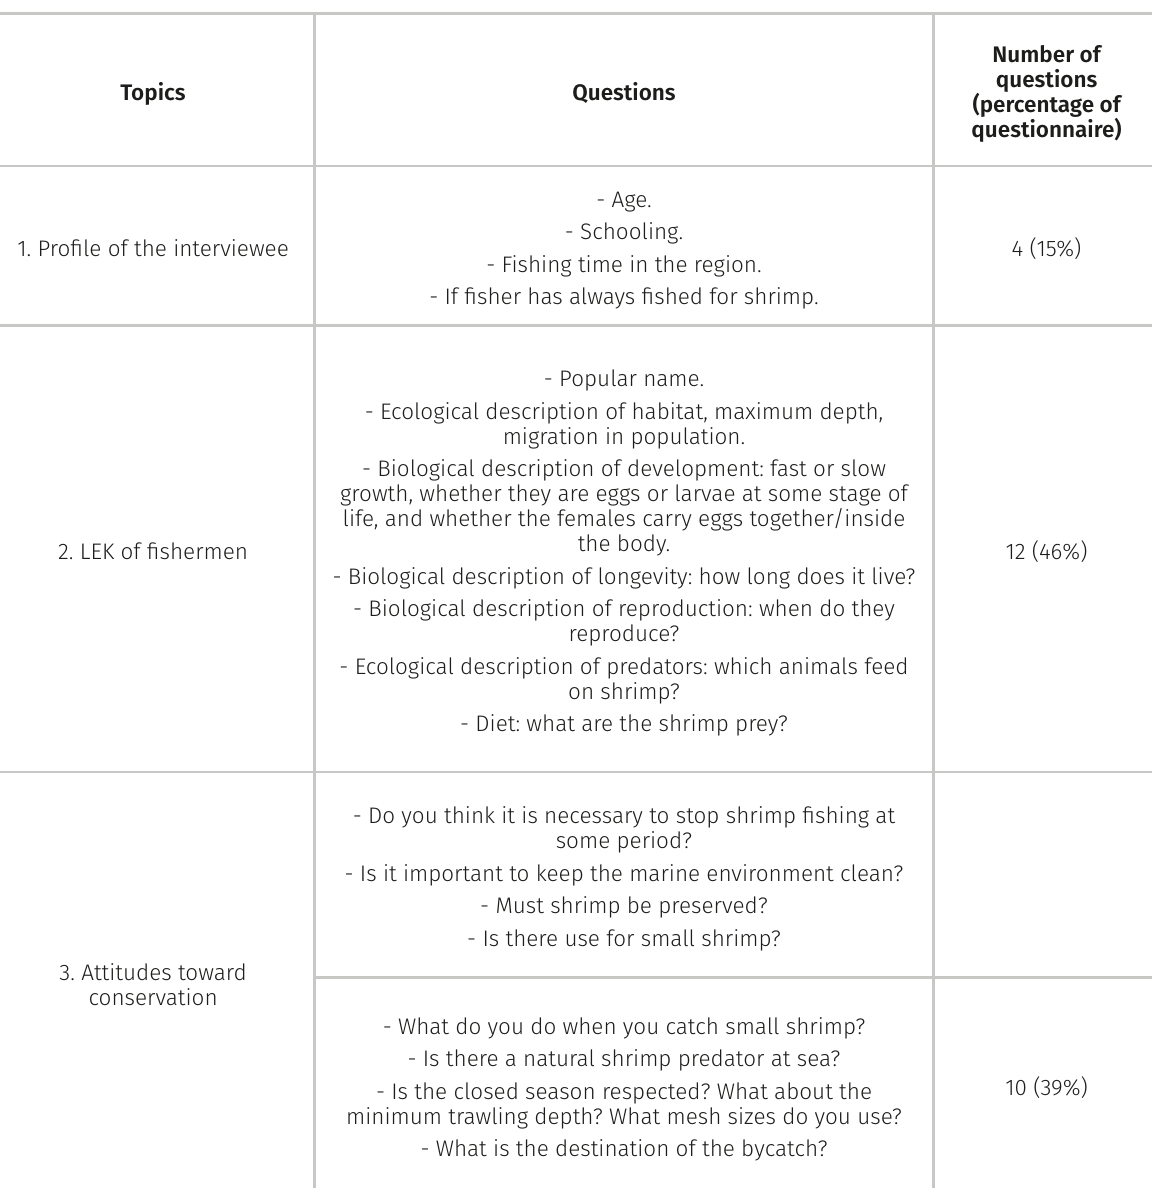
Table I. Elements contained in the semi-structured interviews questionnaire applied to fishermen along the Brazilian central